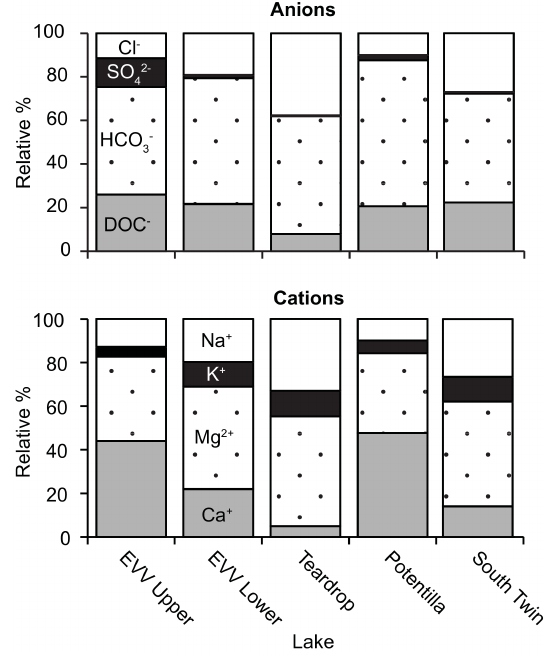
Figure 6. Relative percentages of median total charge associated with anions and cations in water samples from each of the study lakes. We assign the equivalents of missing anionic charge to DOC (Driscoll and Newton, 1985). In all study lakes, HCO − was the 3 dominant anion. SO 2 − was the least abundant anion in all lakes 4 except EVV Upper lake. There was no dominant cation from lake to